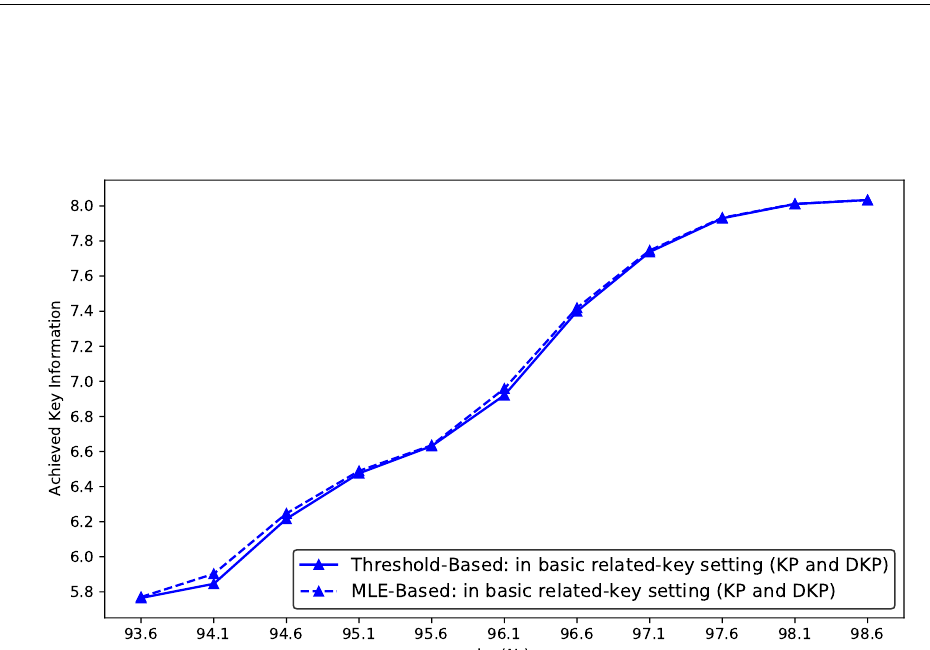
Figure 14: Comparison between the MLE-based model and the threshold-based model of the achieved key information of the basic related-key attacks on TinyJAMBU.